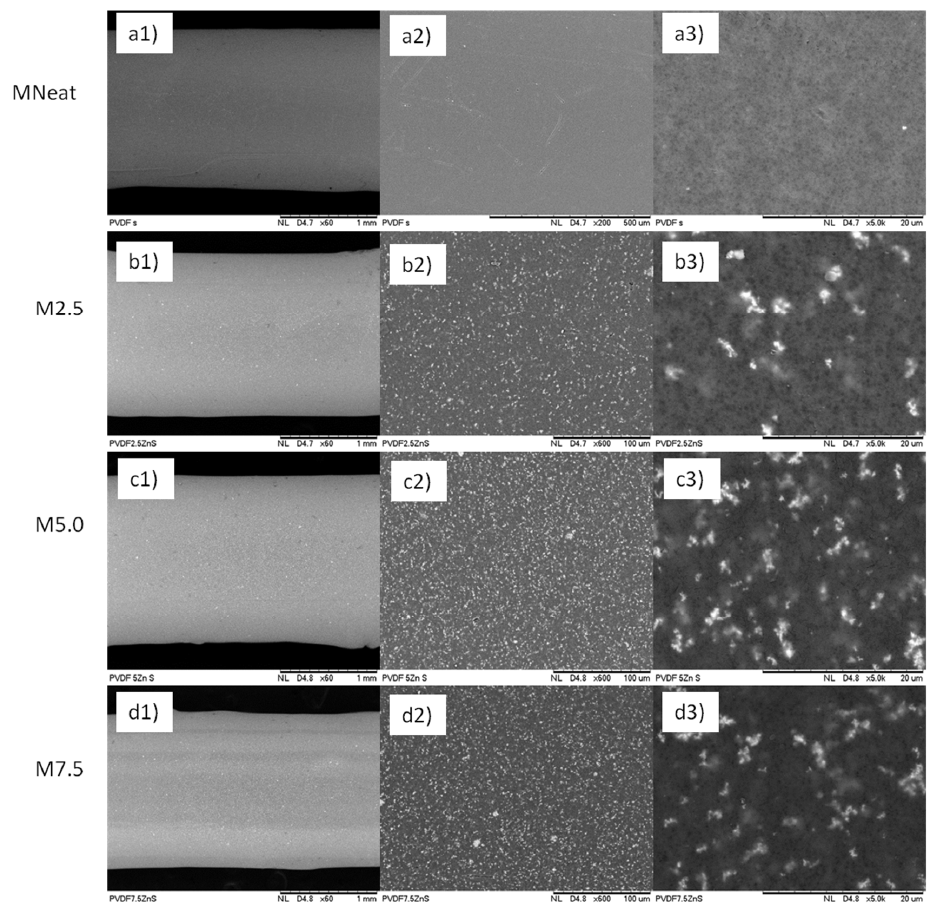
Figure 2. Surface morphologies of ( a1 – a3 ) MNeat ( b1 – b3 ) M2.5 ( c1 – c3 ) M5.0 and ( d1 – d3 ) M7.5 hol- low fiber membranes at different magnification.